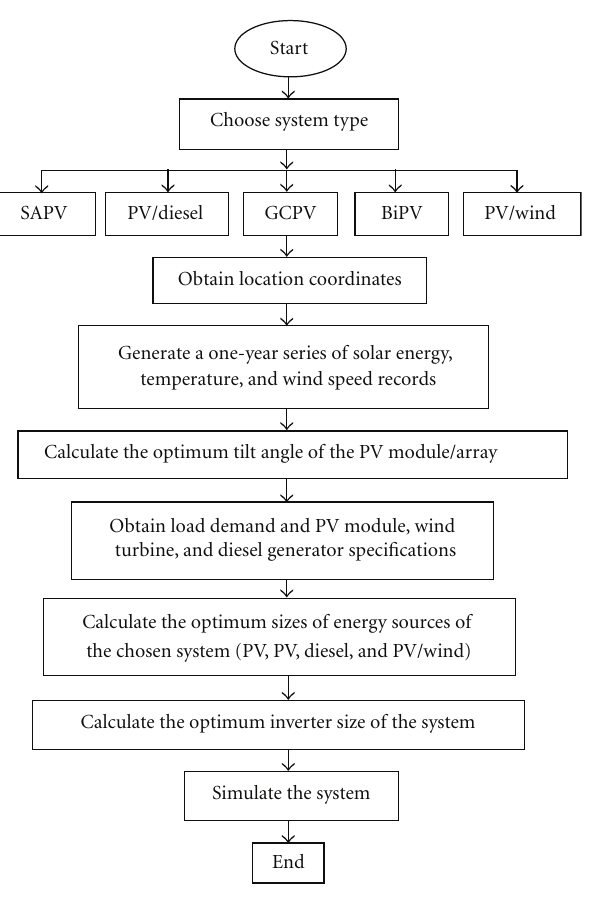
Figure 3: Interface for designing optimal standalone PV